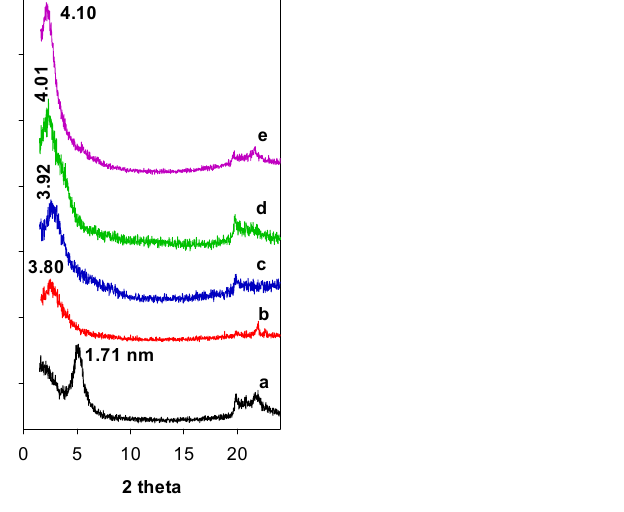
Figure 2. PXRD patterns of the Zr(X) ‐ Mt after reaction with TEOS solution and C12 amine (a) 0, (b) 3, (c) 6, (d) 12, and (e) 24. (c) 6, (d) 12, and (e)